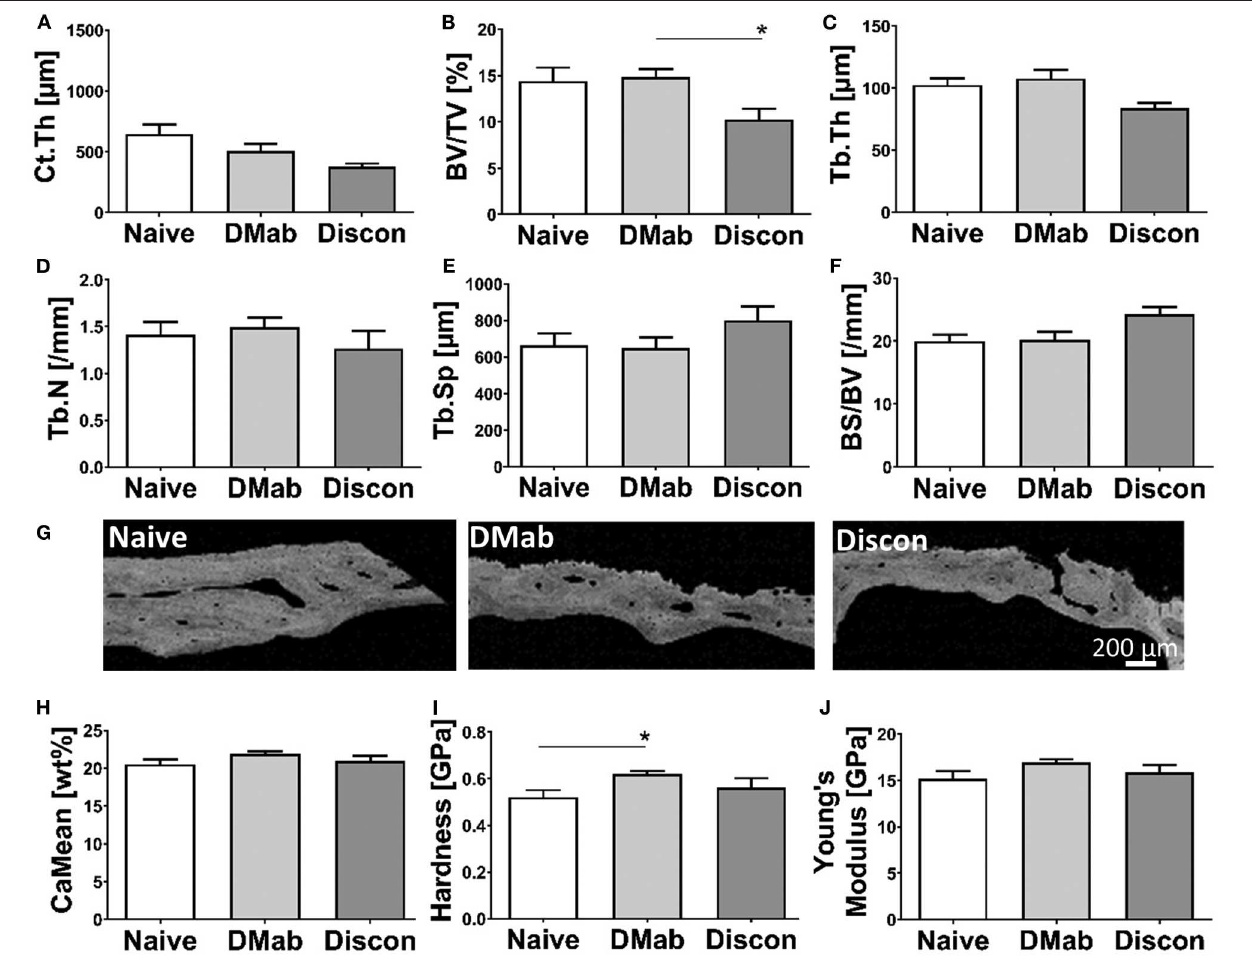
FIGURE 4 | Structural histomorphometry and bone quality evaluation. (A) Cortical and (B–F) trabecular bone sections were stained by von Kossa/van Gieson and structural parameters were assessed by histomorphometry. Measurements include (A) Cortical thickness (Ct. Th.), (B) bone volume per tissue volume (BV/TV), (C) trabecular thickness (Tb. Th.), (D) trabecular number (Tb.N), (E) trabecular separation (Tb. Sp), and (F) bone surface per bone volume (BS/BV). (G) Representative quantitative backscattered electron imaging (qBEI) images of cortical bone. (H) Quantification of averaged calcium mineralization measurements from cortical